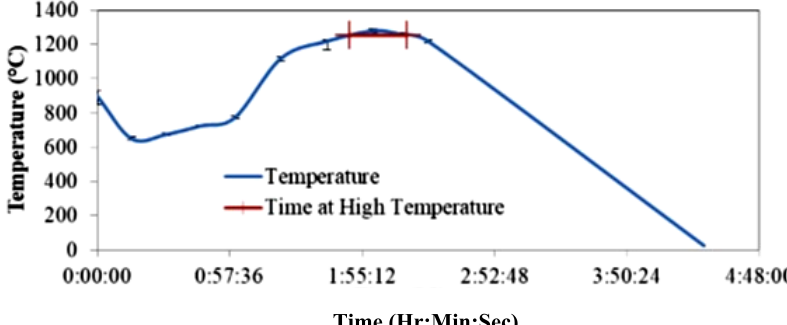
Figure 3. Sintering cycle for PM steel alloy.